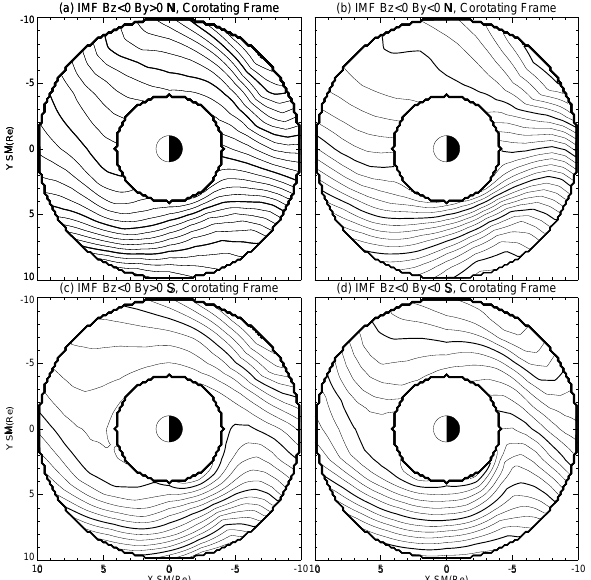
Fig. 2. Electric potential patterns at 4 <L< 10 for all MLT ranges. The conditions are IMF B Z < 0 and indicated as follows for each panel: (a) IMF B Y > 0 in the Northern Hemisphere, (b) IMF B Y < 0 in the Northern Hemisphere, (c) IMF B Y > 0 in the Southern Hemi- sphere, (d) IMF B Y < 0 in the Southern Hemisphere. The patterns are shown in the corotating frame. The contour intervals are 2kV and 10kV for thin and thick lines,